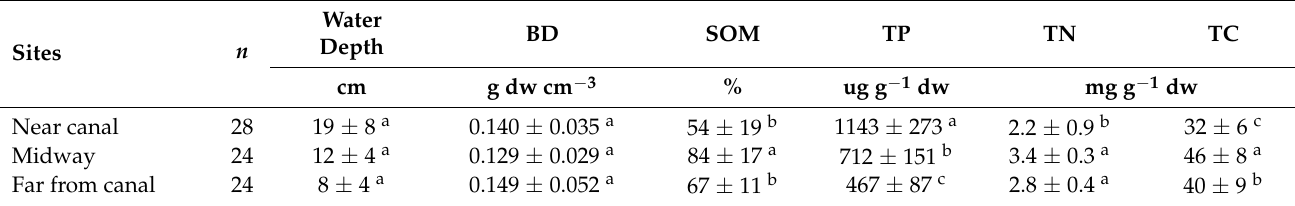
Table 1. Physiochemical parameters (mean ± SD), including water depth, soil bulk density (BD), organic matter (SOM), total P (TP), total N (TN), and total C (TC), at increasing distances from a source canal in the NESS. Different lowercase letters indicate significant differences ( p < 0.05) between